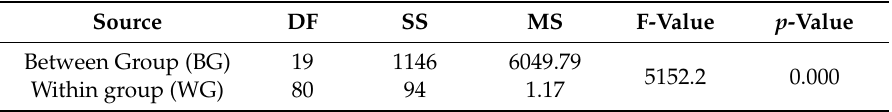
Table 8. The test results of impact